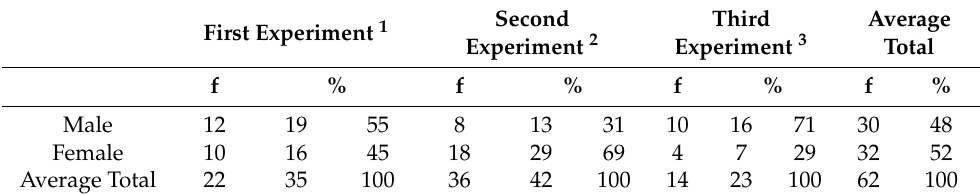
Table 2. Experiments and gender of budding